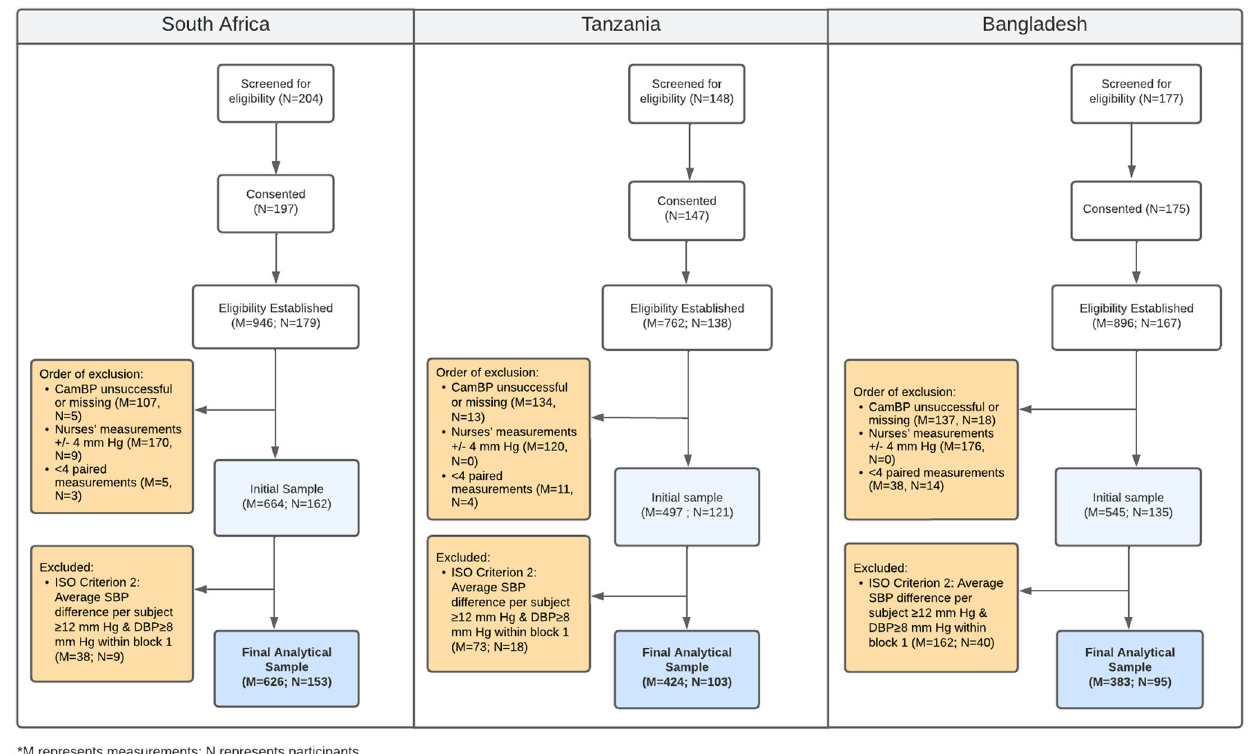
Fig. 2 Flow diagram of the client progress (screening, exclusion and analysis) of the CamBP assessment study in three countries (South Africa, Tanzania, and